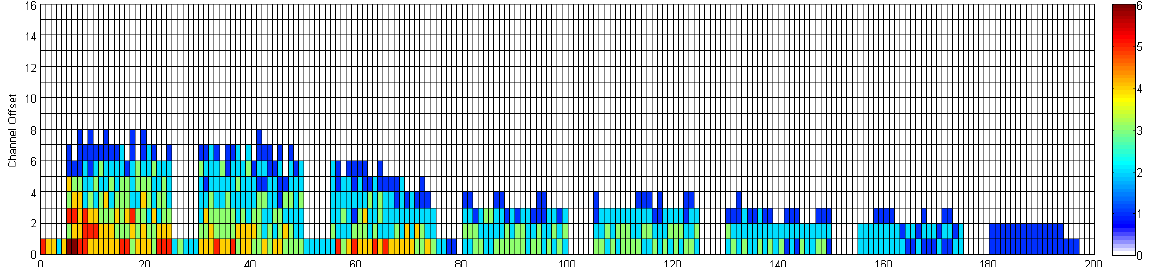
Figure A3. Communication schedule of D-MSR network with 17 nodes per one-hop